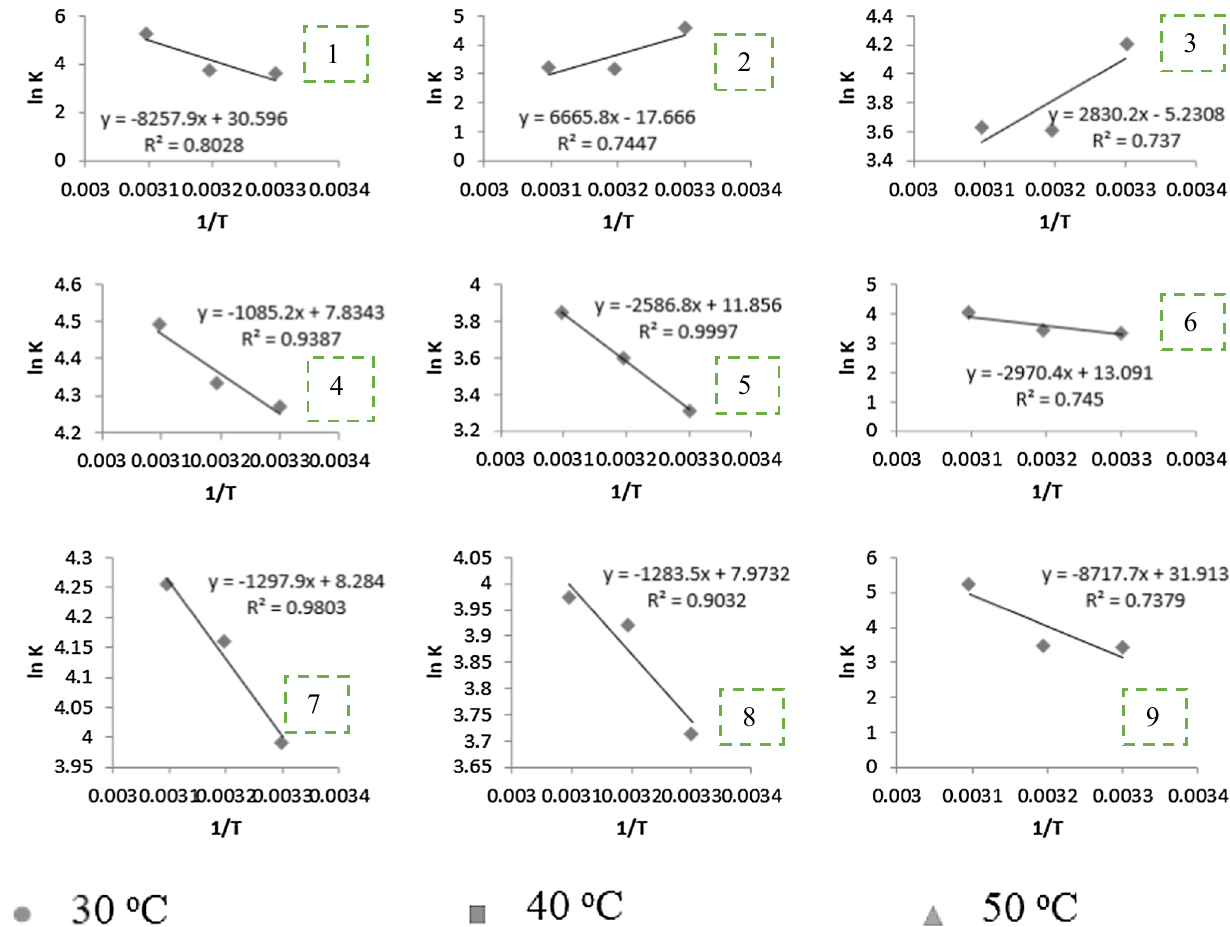
Fig. 7 Thermodynamic graph for samples C1-700 (1), C2-700 (2), C3-700 (3), C1-750 (4), C2-750 (5), C3-750 (6), C1-800 (7), C2-800 (8), and C3-800